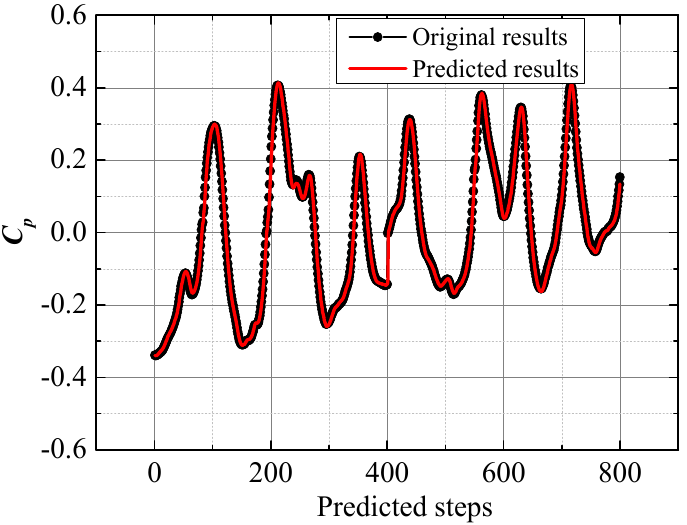
Figure 16. Predicting results of KKF-VSM when an irregular undesired signal existed.